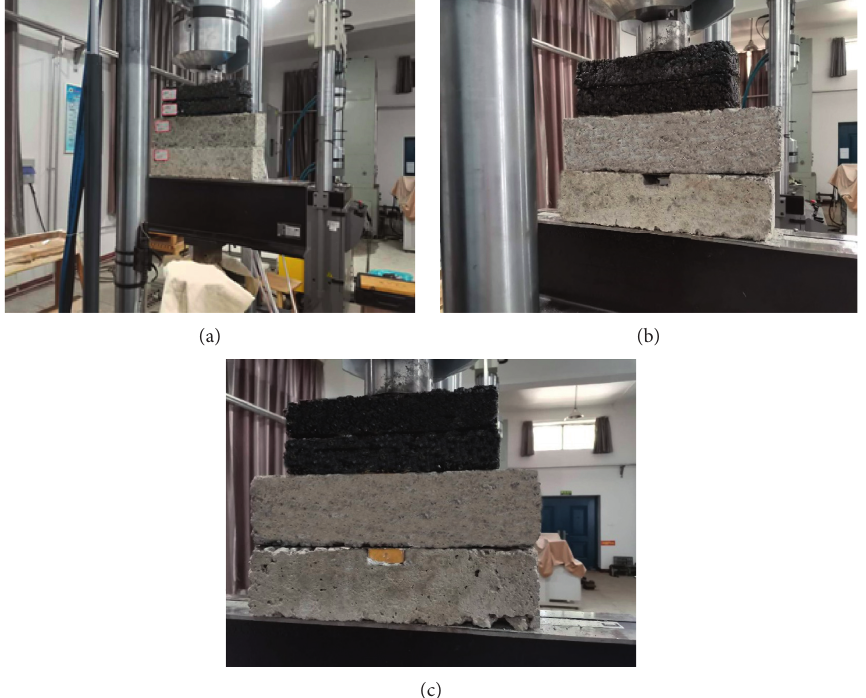
Figure 14: Repeated compression fatigue test diagram of structural model. (a) Compression fatigue test of complete structure model. (b) Compression fatigue test diagram of void structure model. (c) Compression fatigue test diagram of repaired structure